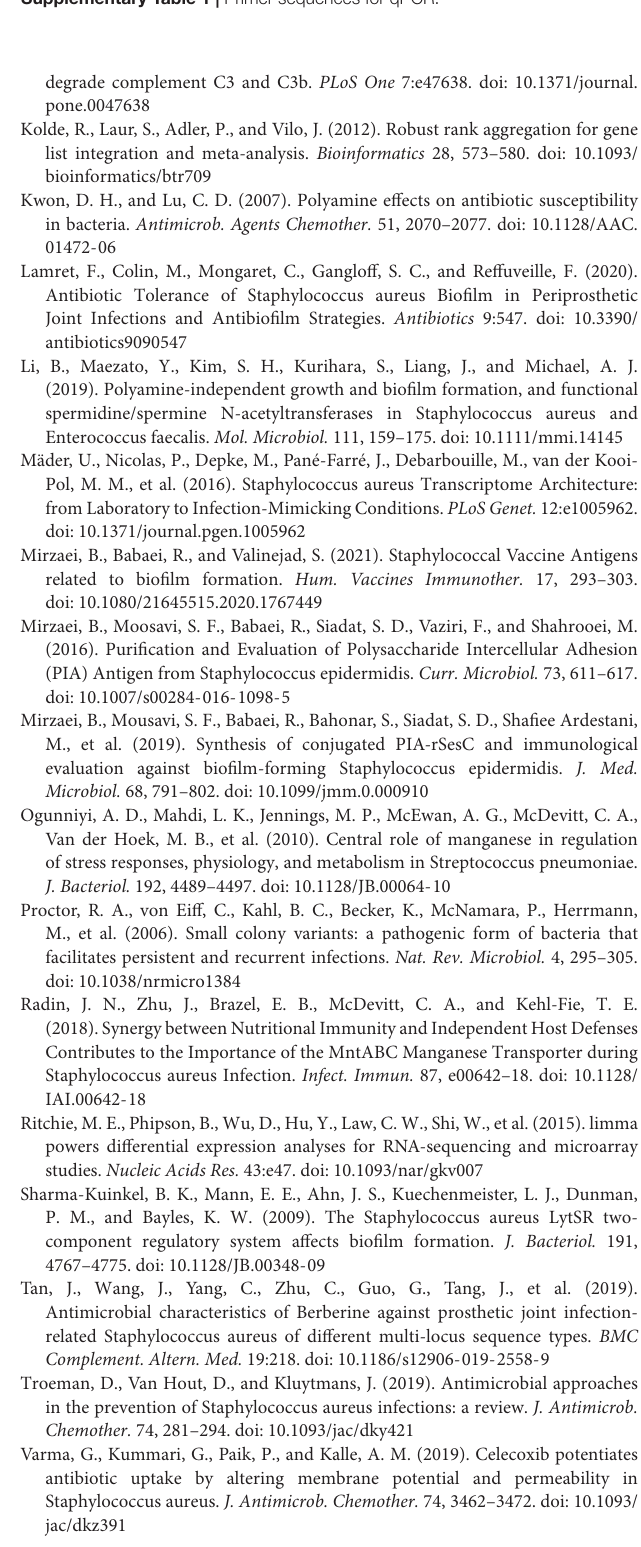
Supplementary Figure 4 | Standardization of gene expression GSE56100. Supplementary Table 1 | Primer sequences for